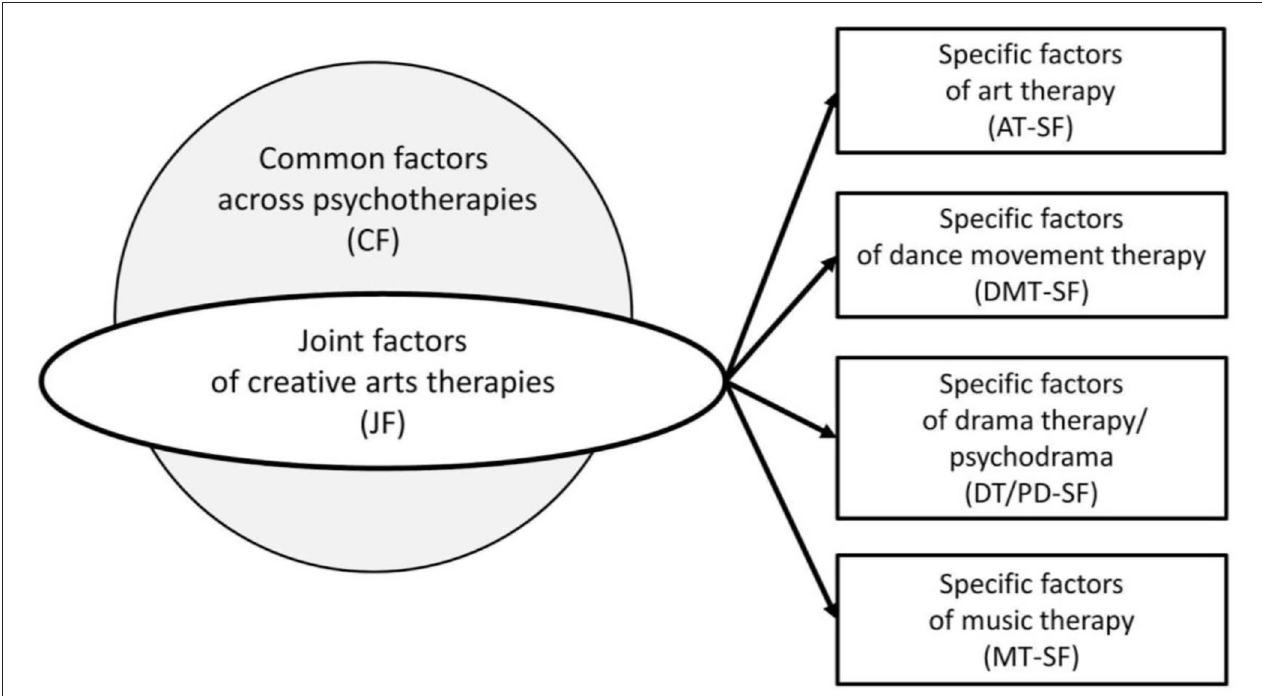
FIGURE 2 | Types of therapeutic